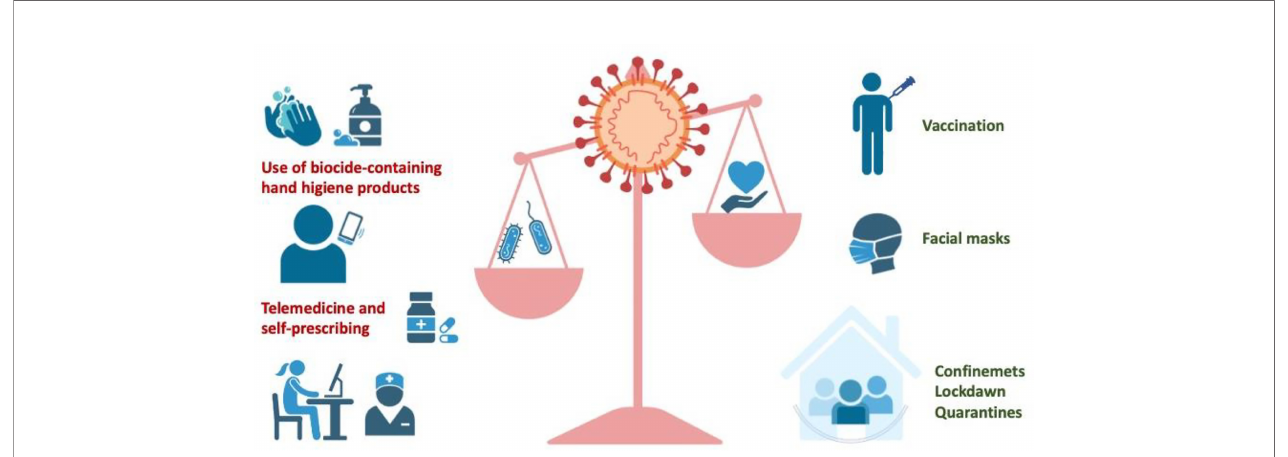
FIGURE 4 | Measures that prevent the spread of SARS-CoV-2 infection may have an impact on the emergence of resistant microorganisms. Vaccination, the use of facial masks, and measures limiting social contacts may result in a decrease in antibiotic prescriptions, limiting the appearance of resistant microorganisms. However, the use of biocide-containing hand hygiene products, telemedicine, and self-prescribing may have increased the use of antibiotics and the release of biocides into the environment, facilitating the emergence of resistant